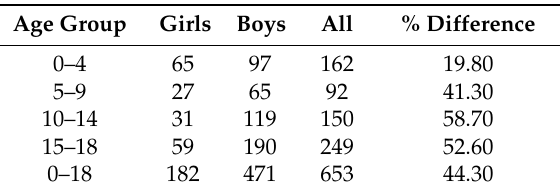
Table 1. Shows the distribution of Traumatic Brain Injury (TBI) by gender. Boys experience the highest rates of injury at all age ranges, but this difference is most pronounced between the age of 10 and 14.